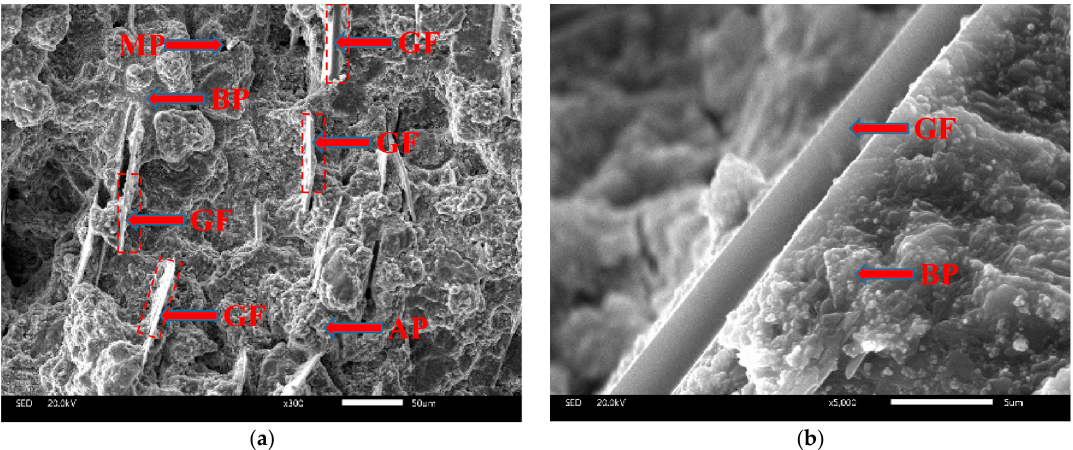
Figure 7. SEM images of the cross-section in GCBPCs: (a) 300×; (b) 5000×. Notes: AP (alumina particles), BP (binding phases), MP (micro-porous).